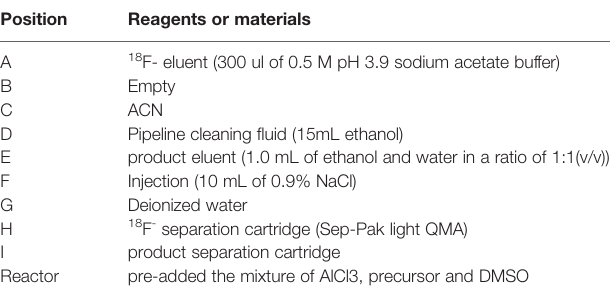
TABLE 1 | Positioning of reagents and materials on AllInOne module for the production of [ 18 F]AlF-FAPT.